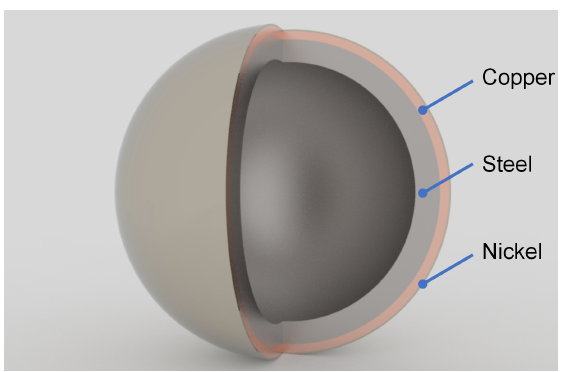
Figure 2. Multilayer spherical shell.